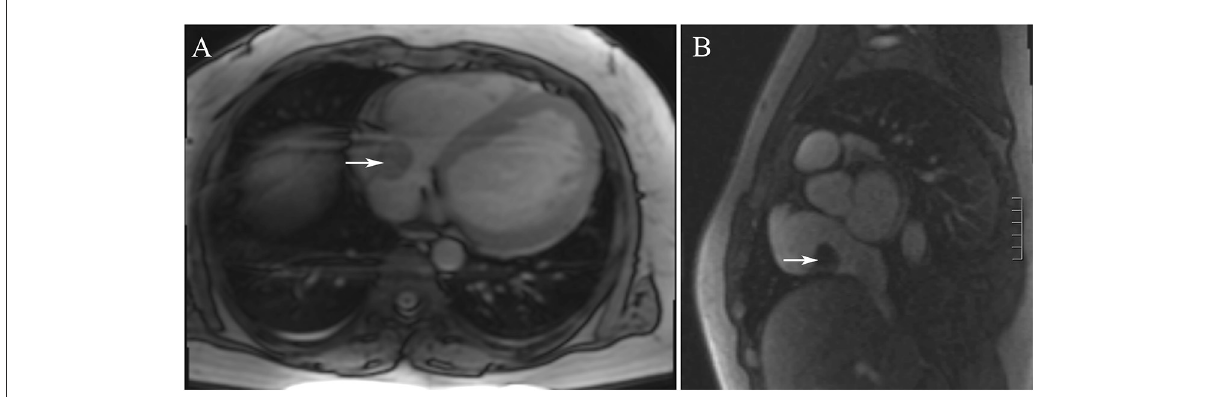
FIGURE2 (A,B) The cardiac magnetic resonance imaging showed that showed that a well-circumscribed, homogenous “shadow” in the right atrium; it measured 29mm × 27mm, had equal T1- and T2-weighted signal intensities, was adjacent to the tricuspid valve.